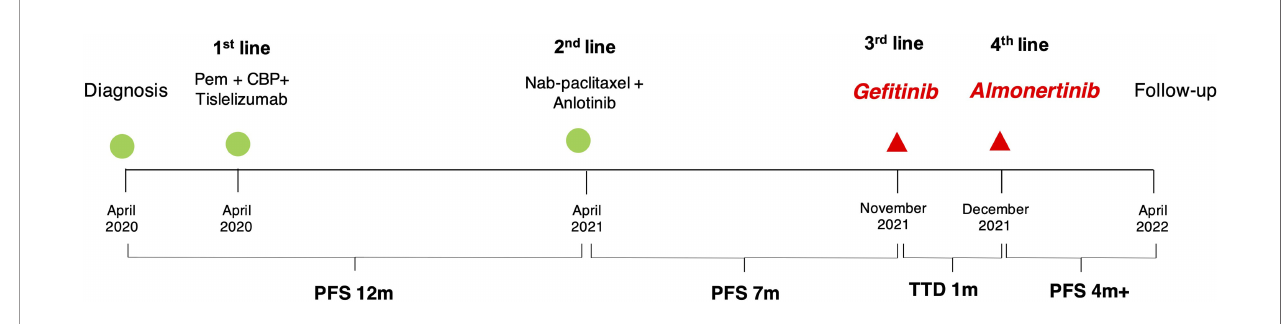
FIGURE 3 | Timeline of patient history. TTD, time to discontinuation; PFS, progress-free survival; Pem, pemetrexed; CBP,